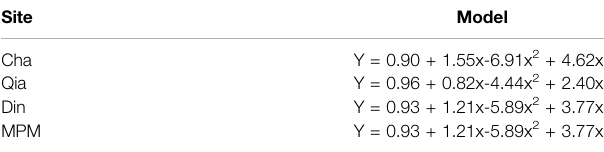
TABLE 3 | The K d model of the four forest FLUXNET